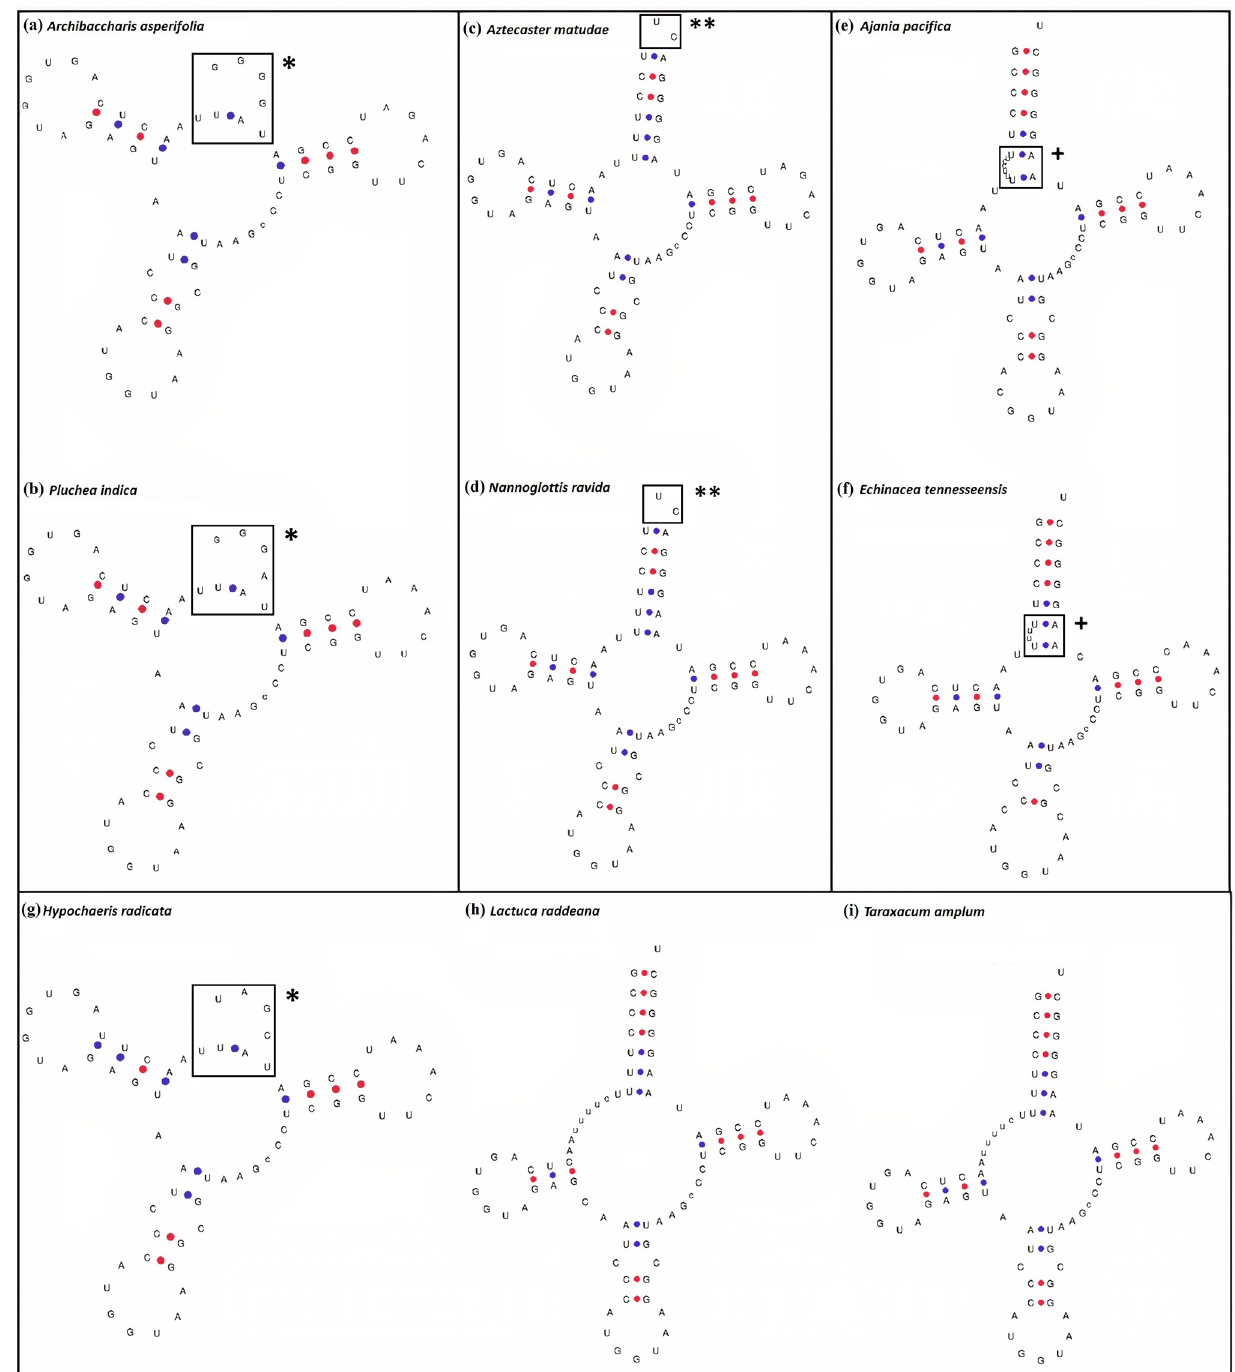
Figure 3. Structure of pseudo or low infernal score trn T-GGU gene in Asteroideae and Cichorioideae. The structure of the gene from ‘a’ to ‘f’ shows the species of Asteroideae, whereas from ‘g’ to ‘i’ represents species of Cichorioideae. ( a and b ) Pseudogenization of the gene occurred due to loss of the acceptor stem. ( c and d ) The genes are predicted with low infernal score (22.6) only by tRNAscan-SE and were not predicted by ARAGORN. However, the mismatch at 5 ′ and 3 ′ indicates that this gene may also be non-functional. ( e and f ) The gene of trn T-GGU predicted as mismatch isotypes for isoleucine. The clear insertion is visible in the acceptor stem, which disturbs the cloverleaf structure. ( g ) Pseudogenization of the gene occurred due to loss of the acceptor stem. ( h ) Indicates the tRNAscan predicted pseudo gene. ( i ) Indicates the tRNAscan predicted gene with low infernal score of 34.6. All the species show the mismatch of c–c, which forms an extra loop-like structure above the codon loop. * indicates loss of the acceptor arm, ** indicates mismatch at 5 ′ and 3 ′ , + indicates the missing of base pair of uridines in the acceptor arm due to